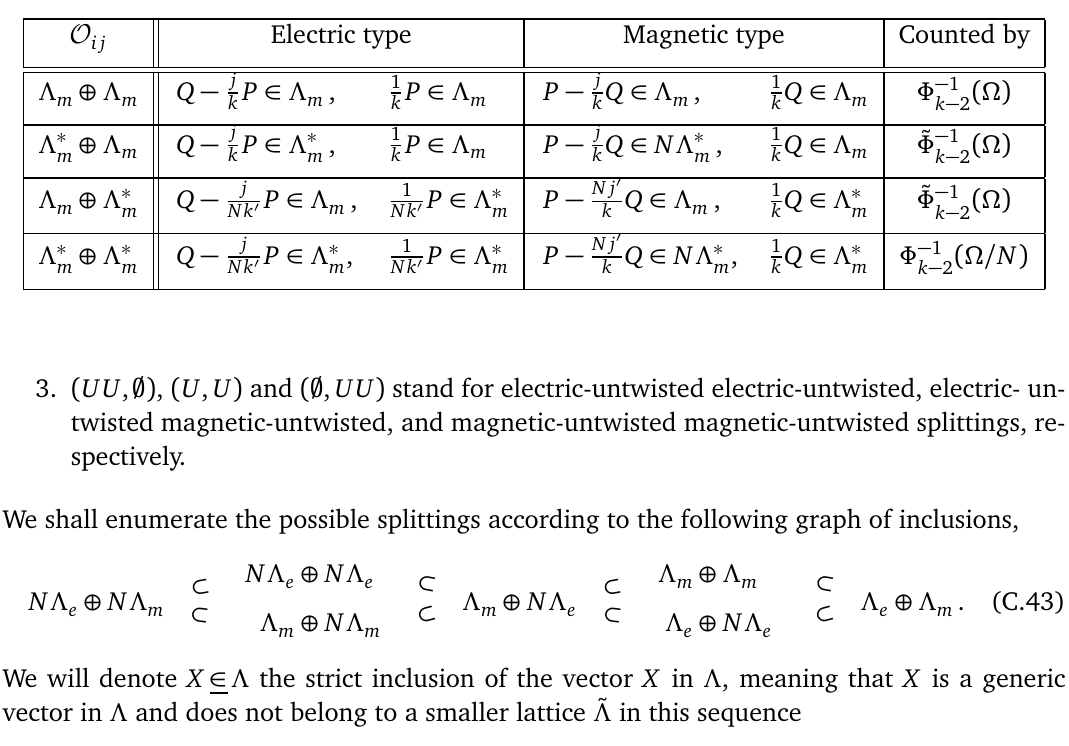
( N ) orbits of splittings from the three terms in (5.75). The first column in- Table 2: Γ 0 dicates the support of B − 1 ( Q , P ) . The second and third columns give the correspond- ing constraints on Γ , Γ , for each of the two possible splittings (C.7) and (C.14). The 1 2 last column records the counting function. We write k = Nk (cid:48) and j = N j (cid:48) whenever k or j are forced to be multiple of N . O is used in the text to denote in the table ij above contribution from row i and column j